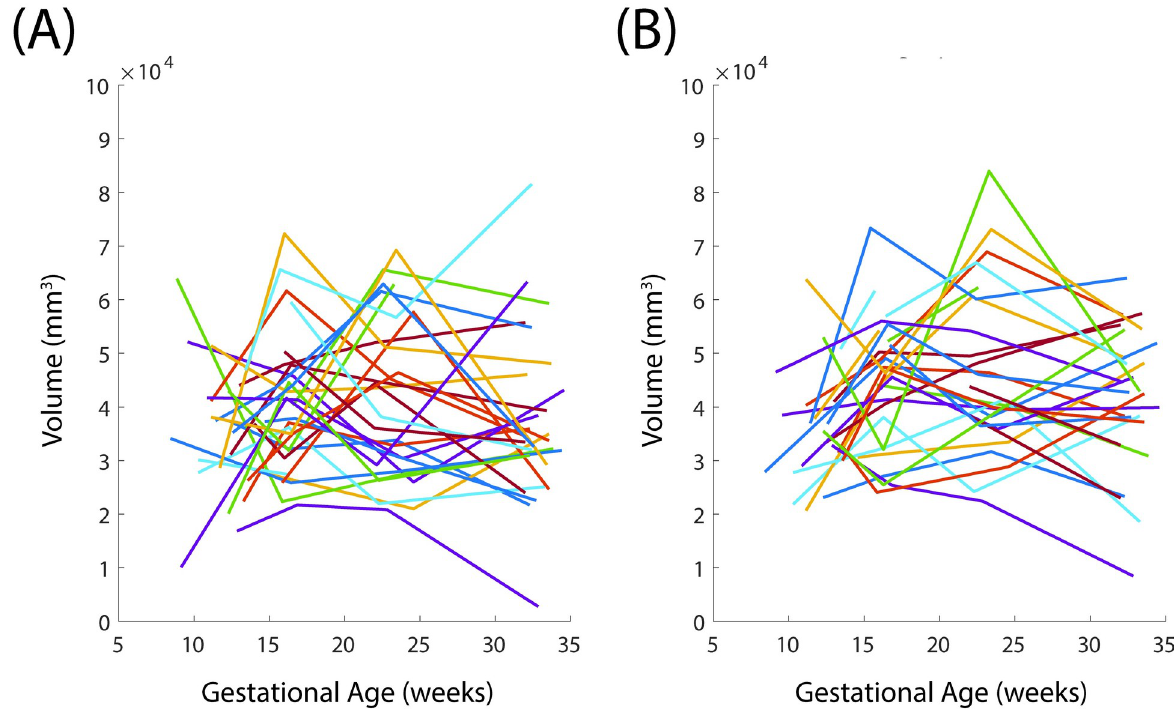
Fig 9. Cervical volume with gestation. Average of (A) standing and (B) supine cervical volume across three sonographers for all visits.